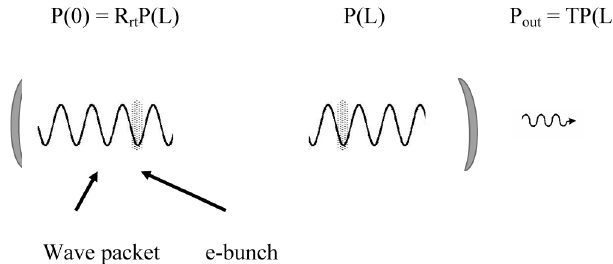
FIG. 7. (Color) Scaling of generated power (cid:5) P (cid:3) L (cid:4) versus input power P (cid:3) 0 (cid:4) of the stimulated (FEL), superradiant (SR), and stimulated-superradiant (ST-SR) emission processes. FIG. 8. The ST-SR oscillator in a Fabri-Perot